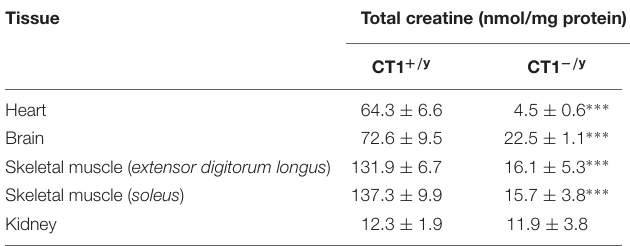
TABLE 1 | HPLC-analysis of total creatine concentrations (mean ± SEM) in CT1 + / y and CT1 − / y mice ( n = 4 per tissue) ( t -test, ∗∗∗ P < 0.001). Tissue Total creatine (nmol/mg protein) CT1 + /